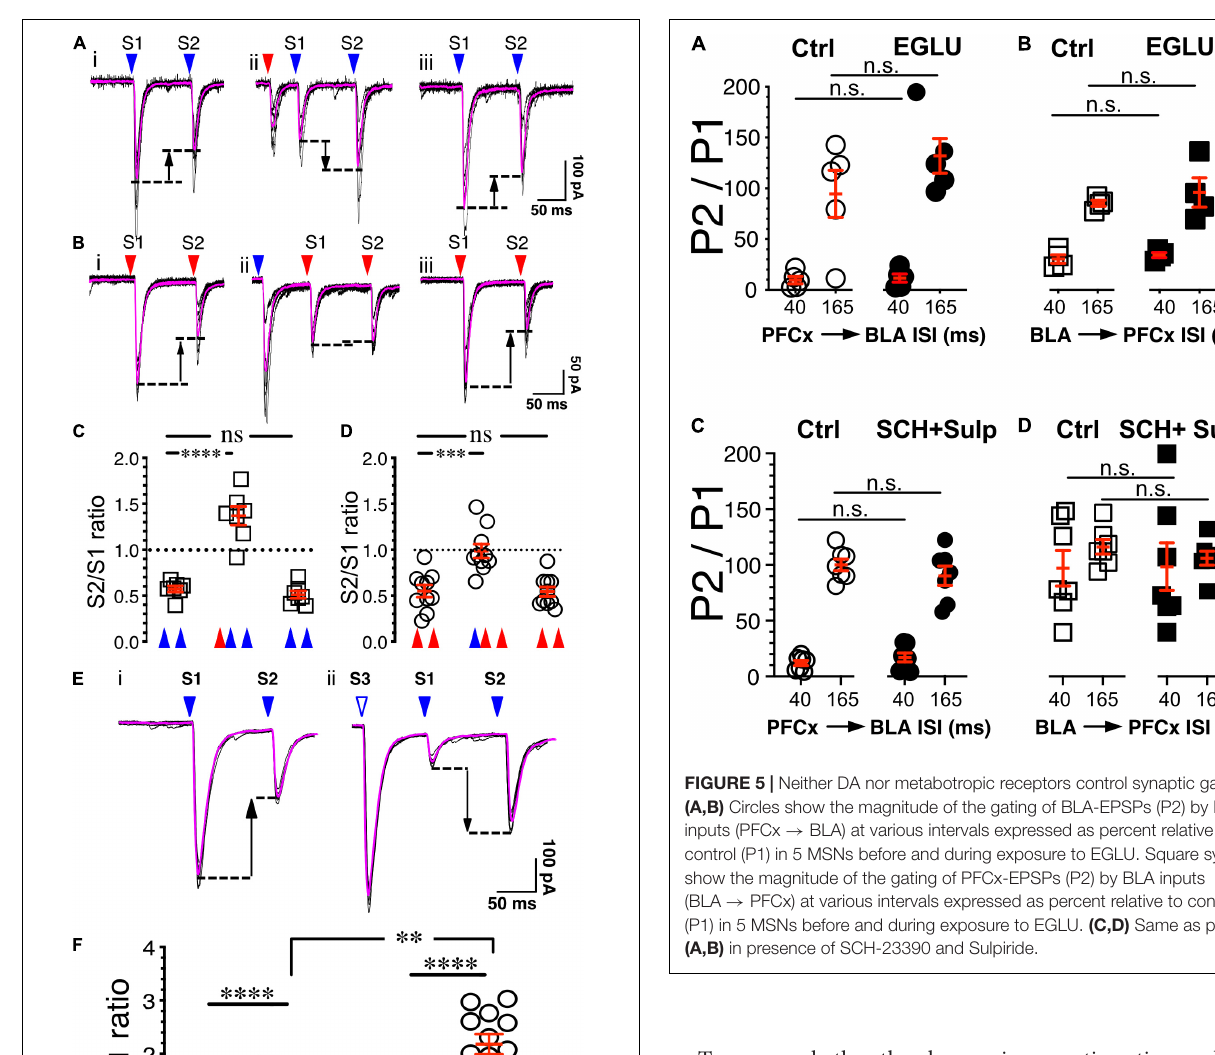
To assess whether the changes in synaptic gating underlying the pre-synaptic control of glutamate release from PFCx terminals by the BLA are similar to the changes in PPR,